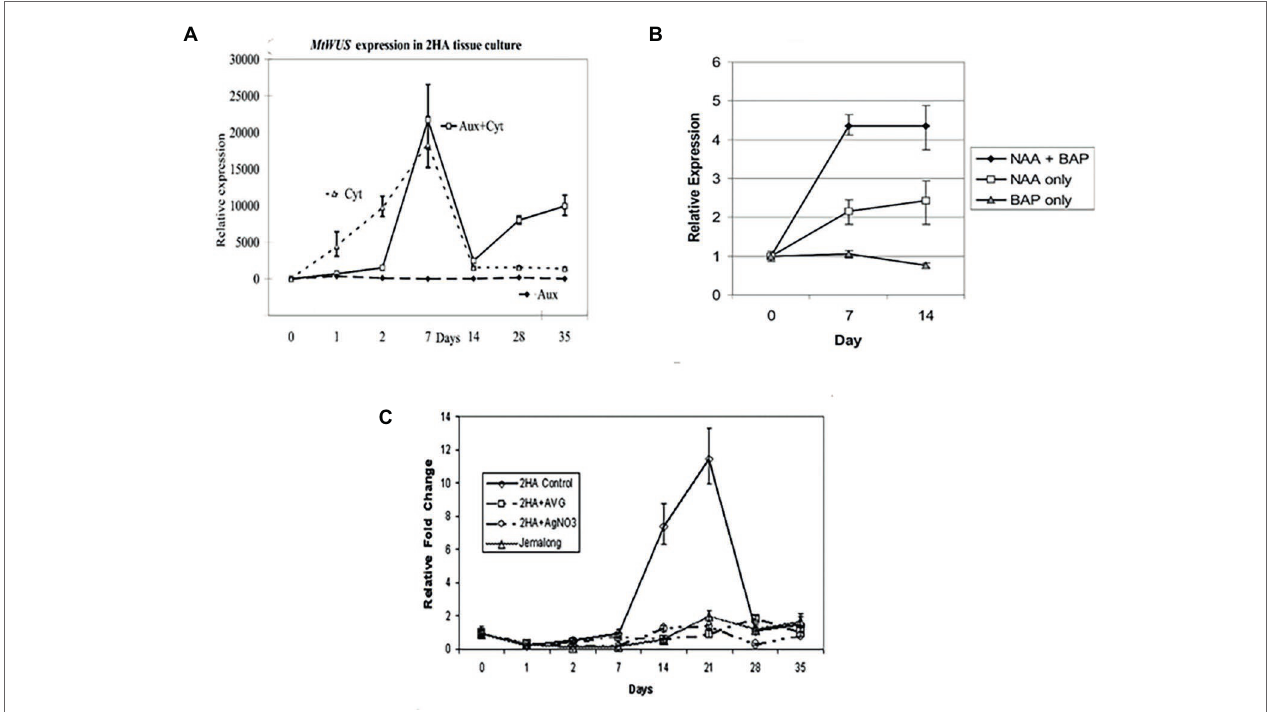
FIGURE 4 | Effects of different hormones on somatic embryo induction. (A) MtWUSCHEL expression; (B) MtSERK1 expression; (C) MtSERF1 expression. AVG (10 μ M aminoethoxyvinylglycine) and AgNO 3 (10 μ M) are ethylene biosynthesis and ethylene perception inhibitors, respectively. Aux = NAA = 10 μ M 1-naphthalene acetic acid, Cyt = BAP = 4 μ M 6-benzylaminopurine. (A) From Chen et al. (2009), authors’ copyright. (B) From Nolan et al. (2003), www.plantphysiol.org, Copyright American Society of Plant Biologists. (C) From Mantiri et al. (2008a,b), www.plantphysiol.org, Copyright American Society of Plant